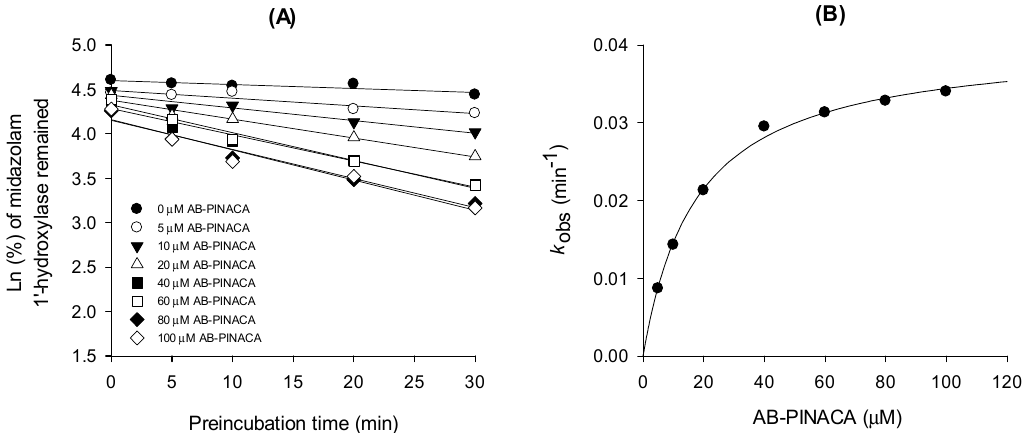
Figure 3. ( A ) Inactivation kinetics of midazolam 1 ′ -hydroxylation by AB-PINACA (5–100 µM) in ultrapooled human liver microsomes and ( B ) the relationships between the k obs values and the AB-PINACA concentrations for the determination of the K i and k inact values for time-dependent inhibition of CYP3A4 activity.